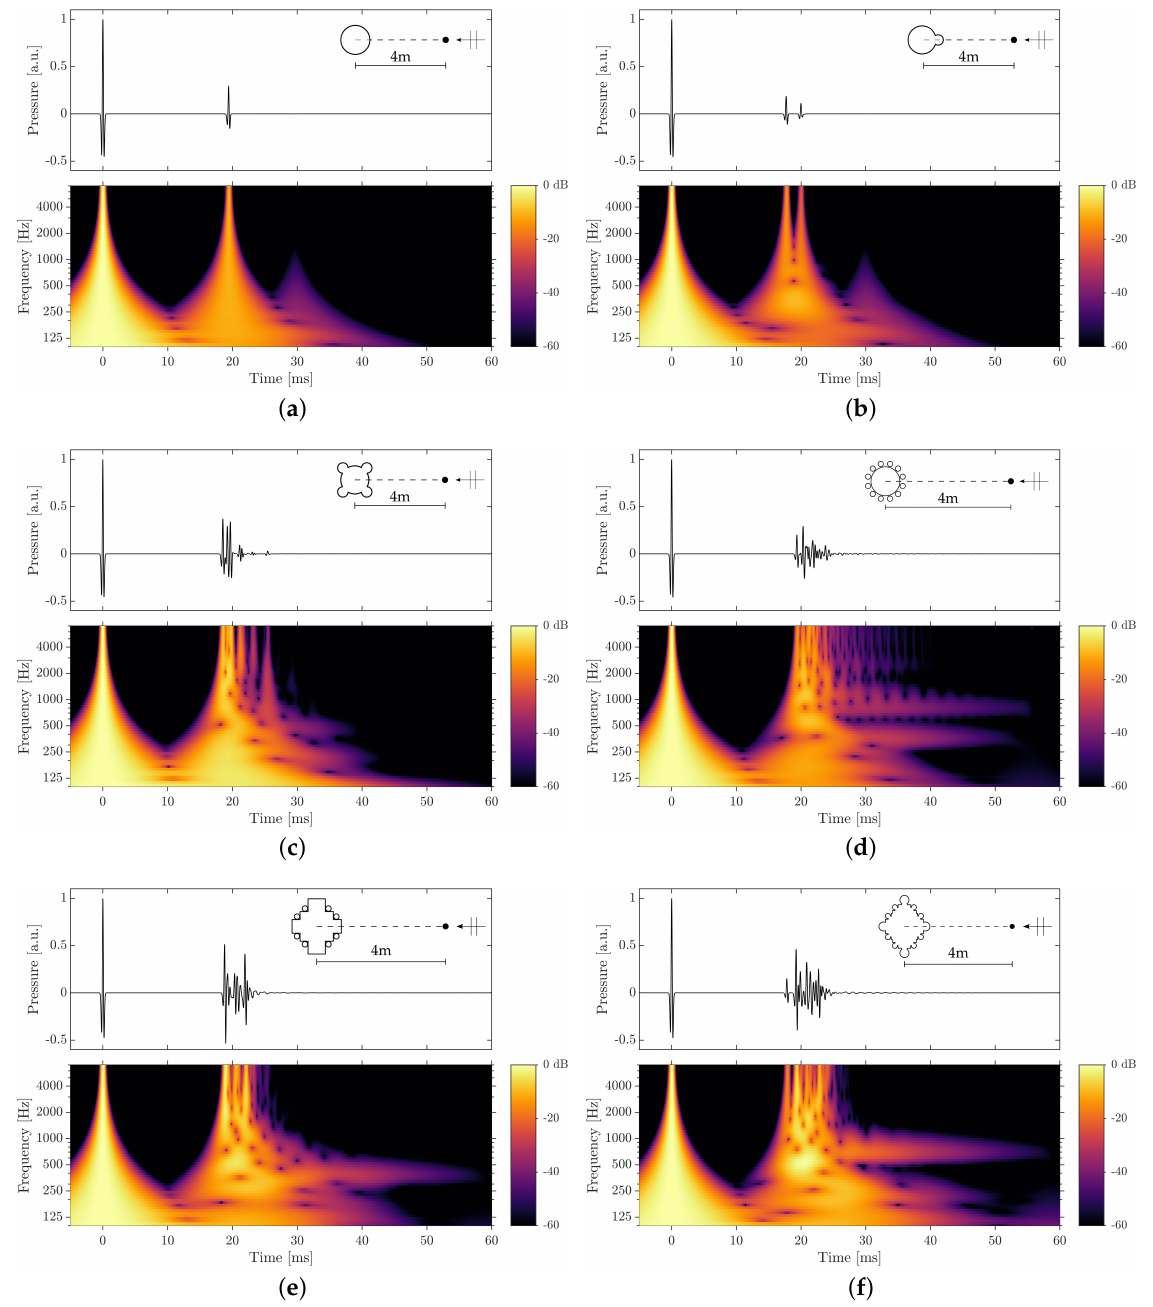
Figure 8. Pressure signal ( top ) and corresponding wavelet scalogram ( bottom ) normalized by the free-field maximum for ( a ) a circular cylinder of diameter 133 cm, ( b ) N2 with θ 0 = 90°, ( c ) N1 with θ 0 = 45°, ( d ) N3 with θ 0 = 0°, ( e ) C2 with θ 0 = 90°, and ( f ) T with θ 0 = 0° at 4 m from their center in the backscattering